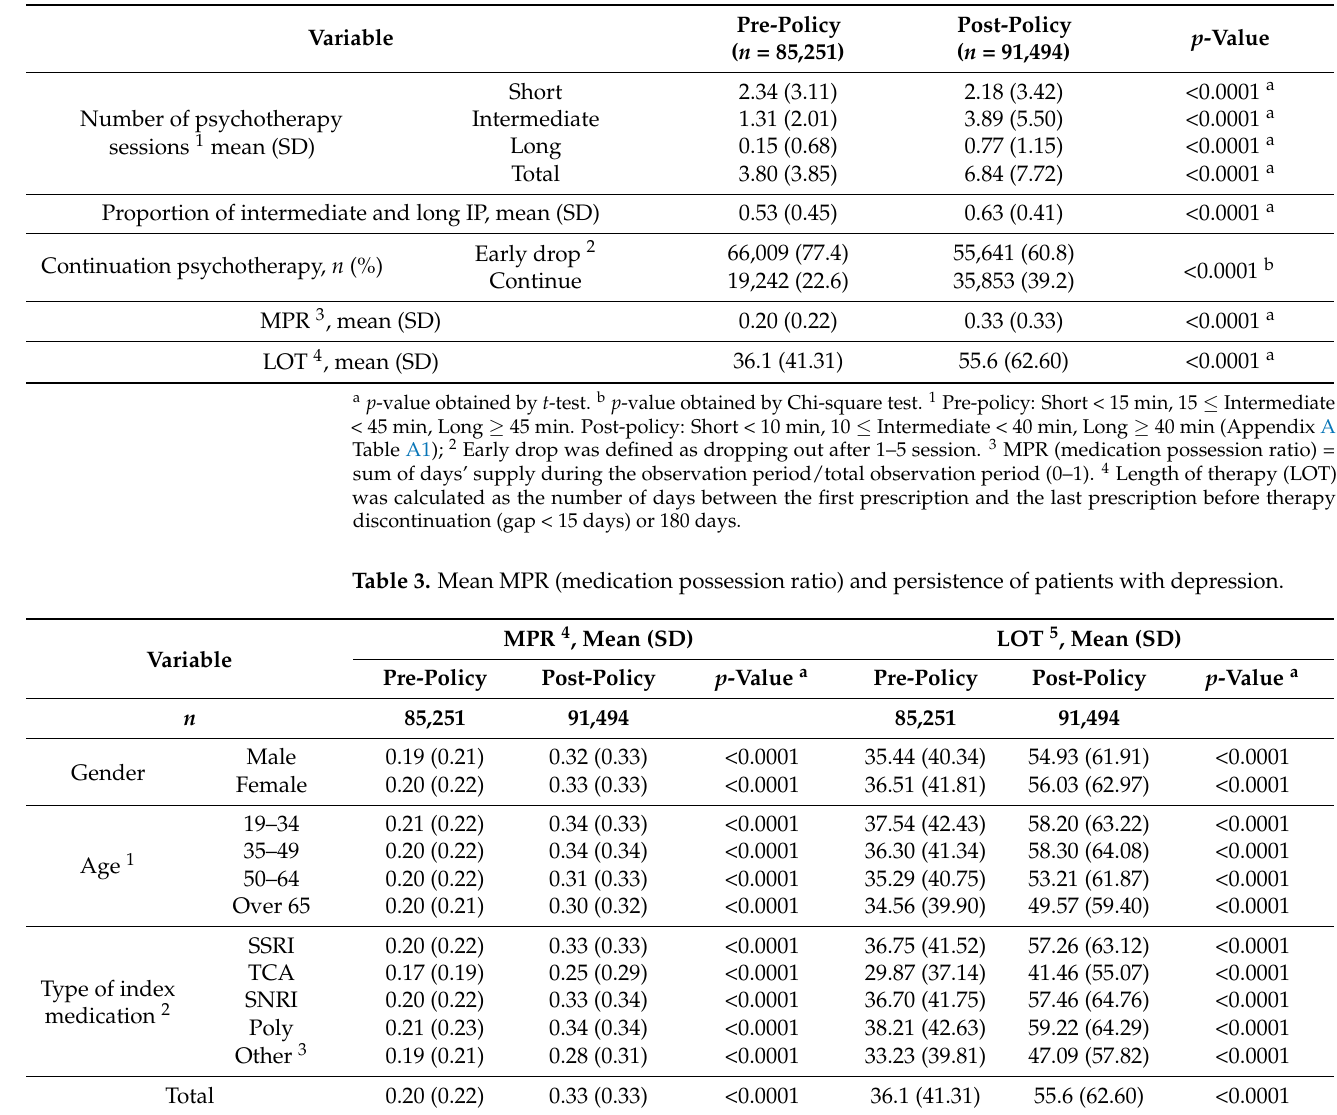
Table 2. Number of IP sessions, medication adherence, and persistence by payment scheme.